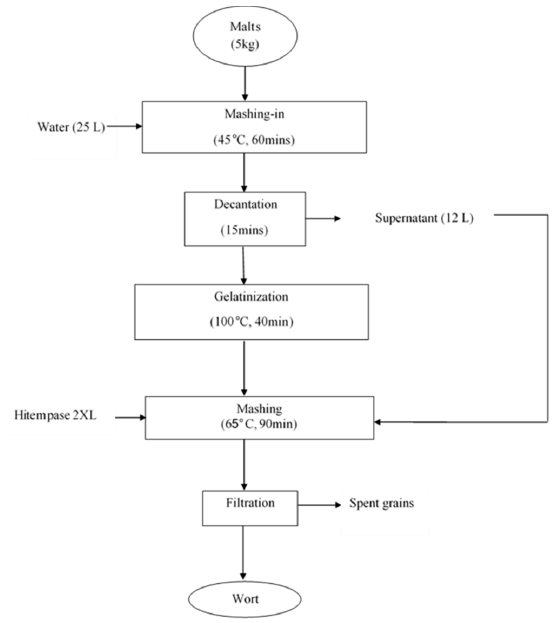
Figure 8. Decantation mashing process. Table 2. Sorghum malt types and quantities used during